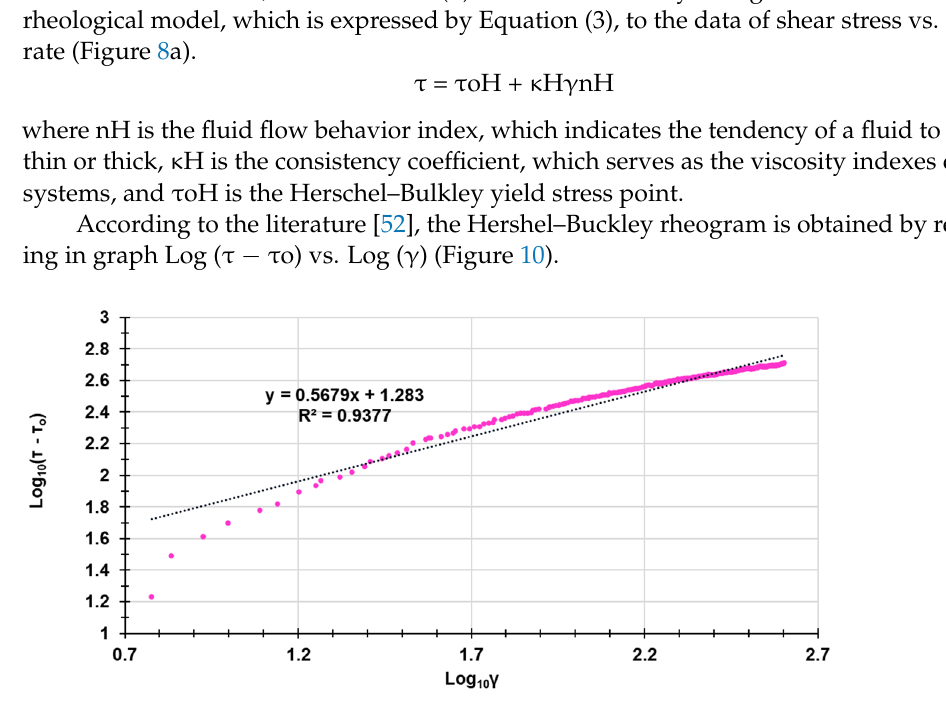
Figure 10. Hershel–Buckley rheological model.